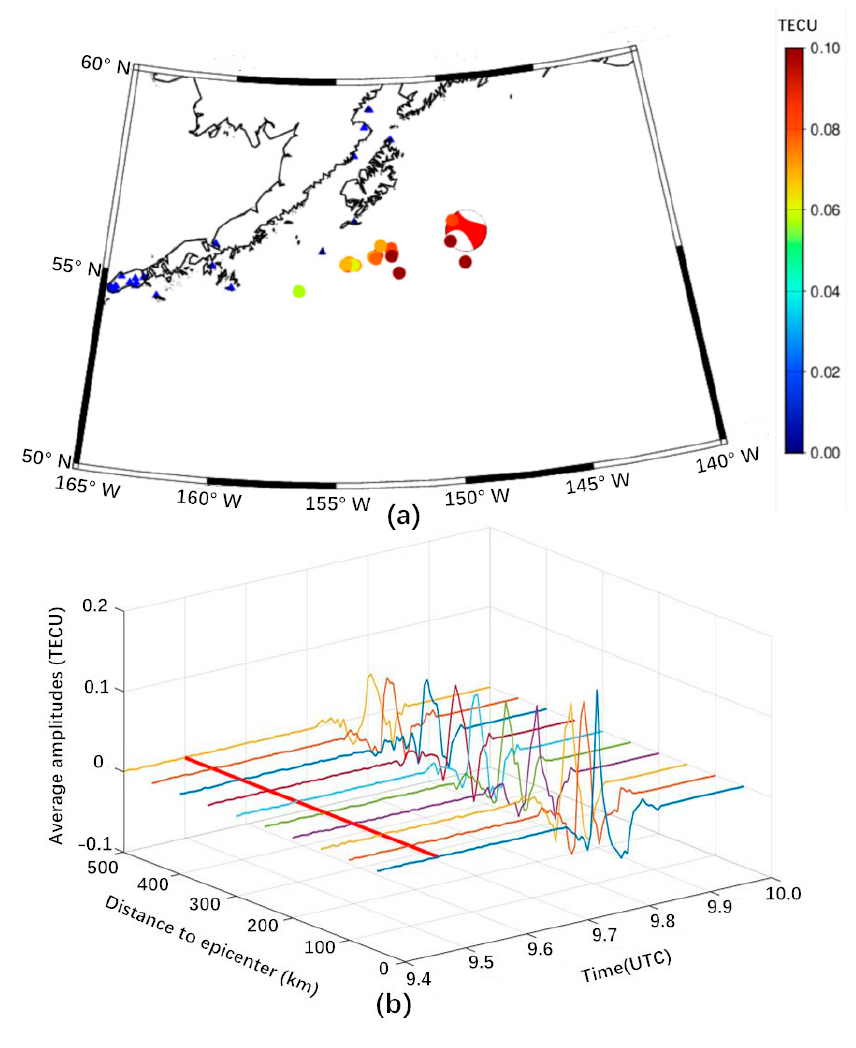
Figure 8. Attenuation of CID amplitude. ( a ) Peaks of CID near the epicenter, the color depth represents the amplitude of the ionosphere disturbance, and the beach ball represents the epicenter. ( b ) The average amplitudes of relative STEC extracted by singular spectrum analysis (SSA) with the distance to the epicenter during UTC 09:00–10:00, 0–500 km. The red line indicates the time of the Alaska earthquake.